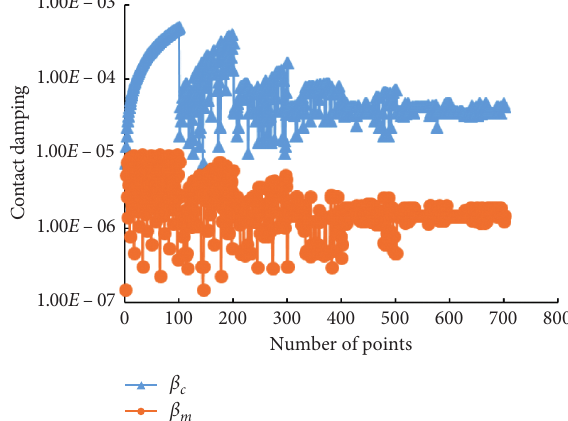
Figure 15: Convergence of model parameters under the torque of